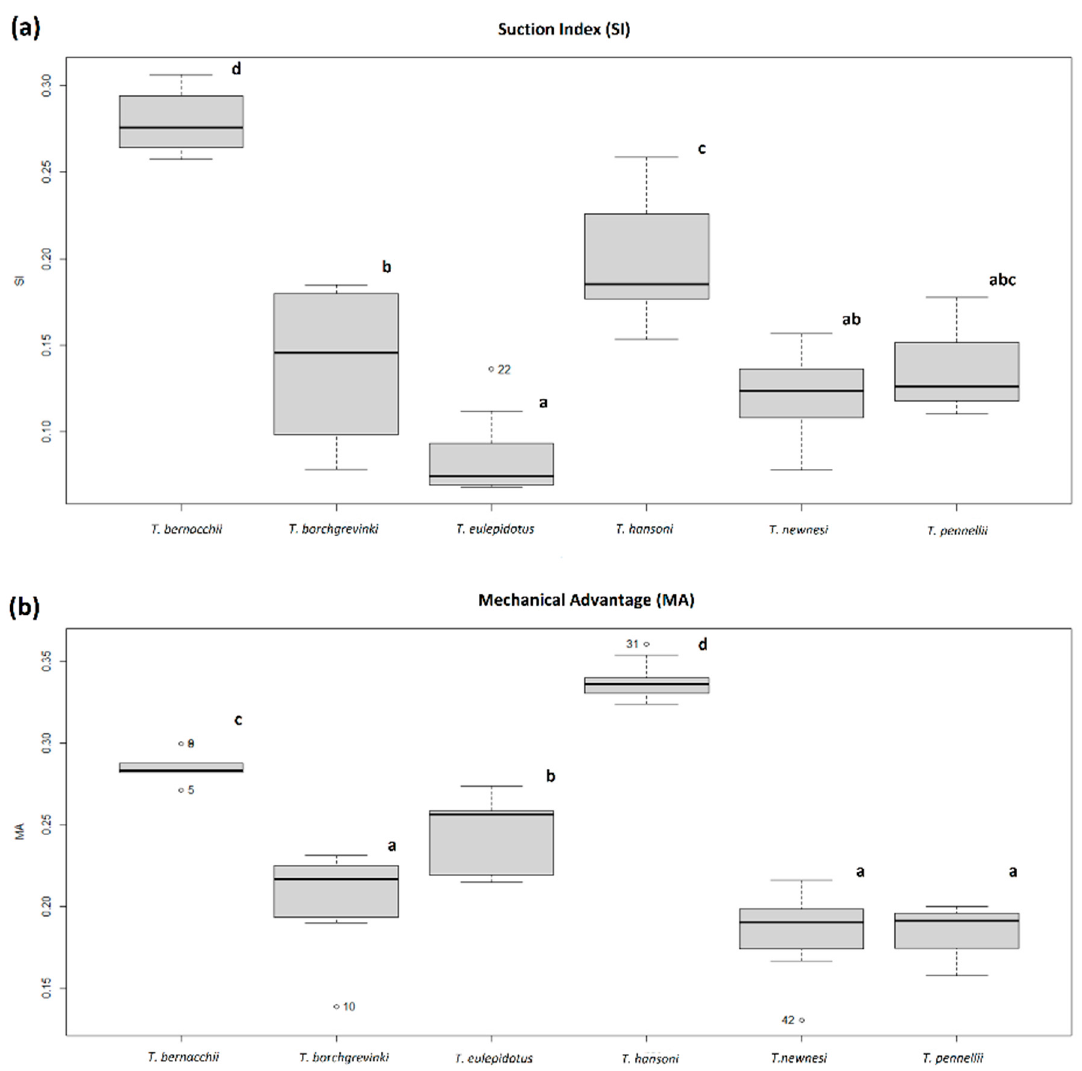
Figure 2. Boxplots of the values of Suction Index ( a ) and Mechanical Advantage ( b ) calculated for the six investigated species. Different letters in the boxplots indicate significant differences.